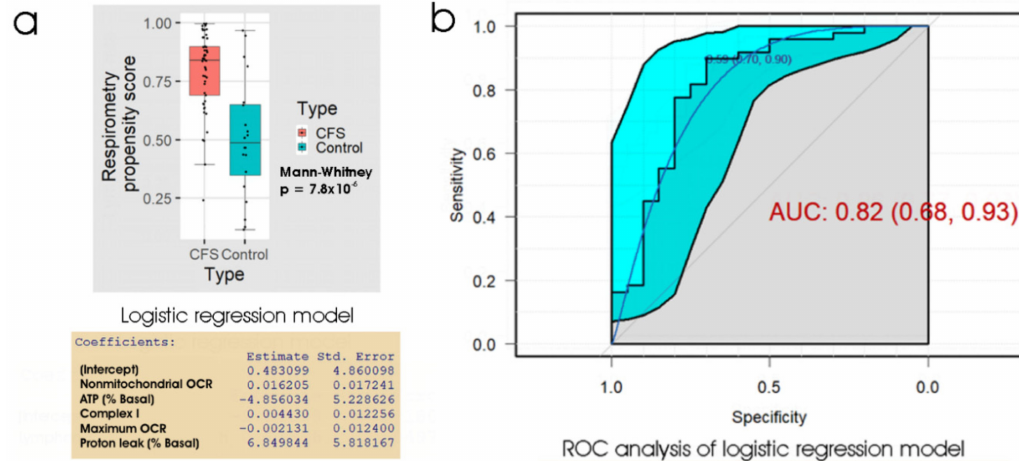
Figure 4. Logistic regression and ROC analysis of lymphoblast respiration as an ME / CFS biomarker. ( a ) Box plot showing the distribution of the propensity score from logistic regression of participant type against 5 key respiratory parameters. The resulting regression coe ffi cients are as indicated. The boxes show the median and the 25 th and 75 th percentiles, so that the height of the box is the interquartile range (IQR). The whiskers extend to the most extreme observations (largest and smallest) falling within ± 1.5 × IQR of the box. The ME / CFS and control sample sizes were 49 and 20 individuals, respectively. The Mann–Whitney significance probability tests the hypothesis that the scores in ME / CFS samples are greater than in control samples. Each point represents a single individual. Scores greater than 0.5 lead to classification of a sample as ME / CFS in the “confusion matrix”. Other relevant statistics showing that the logistic regression model provided a good fit to the data were: Hesmer–Lemeshow goodness of fit = 0.14; Pseudo R 2 = 0.56; χ 2 p = 6.7 × 10 − 4 . ( b ) ROC analysis of the propensity score, plotting sensitivity (proportion of true positives) against specificity (proportion of true negatives) with 95% confidence limits (cyan shading). The fractional area under the curve (AUC) is shown with 95% confidence limits. The “best” threshold for the propensity score (0.59) is shown, together with the specificity (0.70) and sensitivity (0.90) at that threshold (in